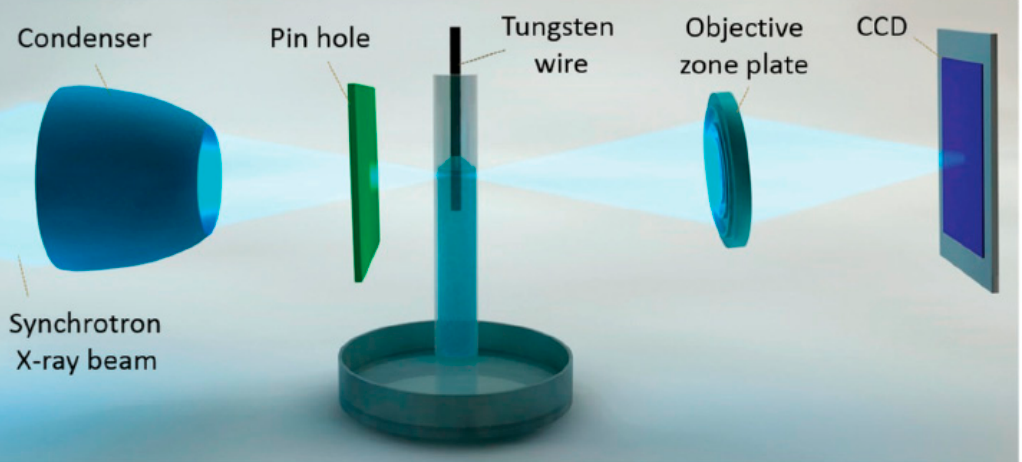
Figure 14. Examination of electropolished tungsten in KOH solution where wire is surrounded by gel-like structure [130]; copyright granted by author (Konstantin, 2015 [130]).